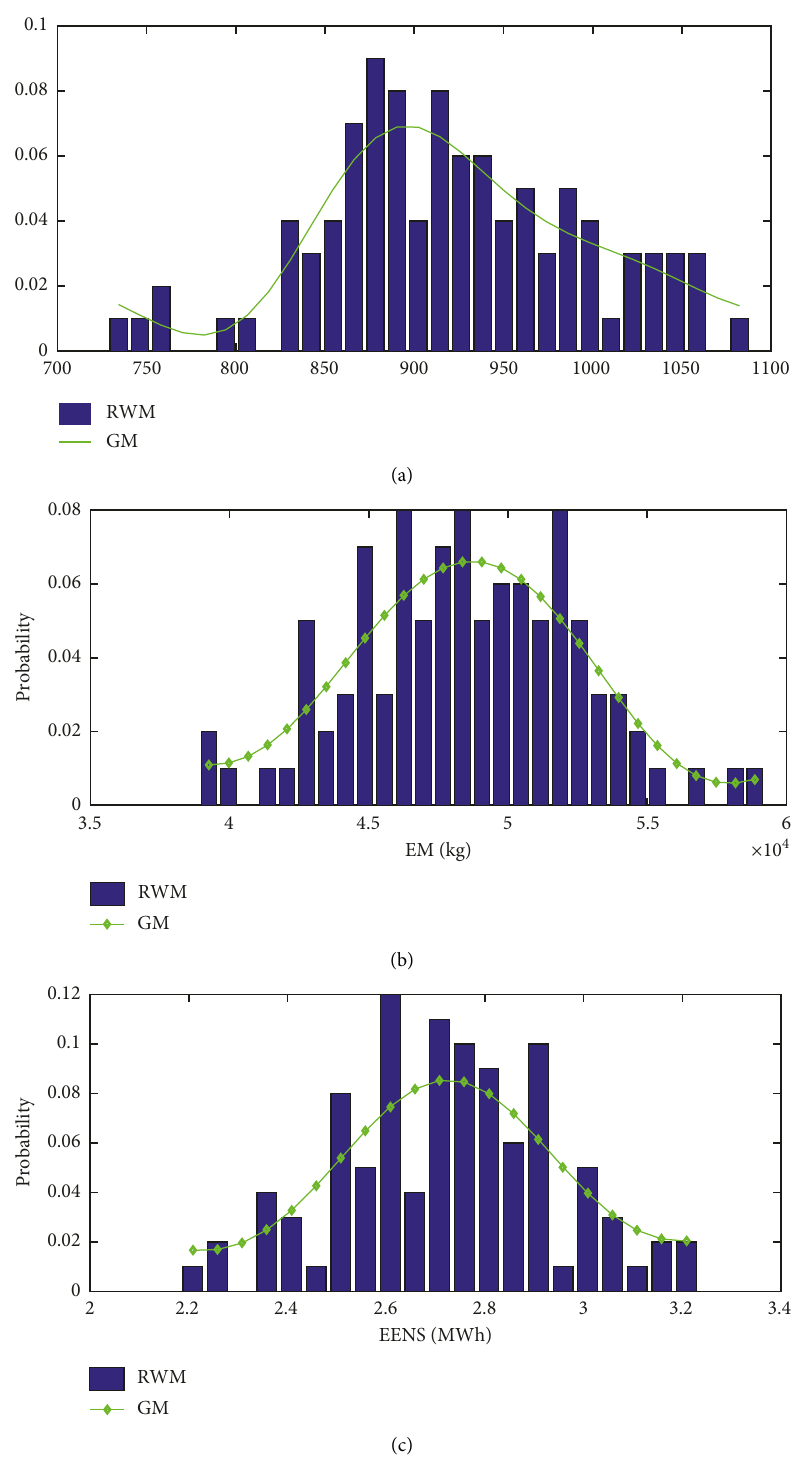
Figure 5: PDF of (a) Cost, (b) EM, and (c)